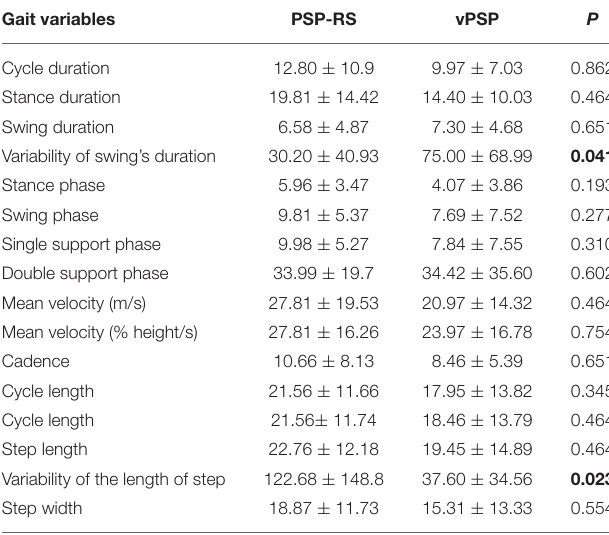
Data are shown in mean ± standard deviation. PSP-RS, Progressive Supranuclear Palsy with Richardson’s syndrome; vPSP, the other variant syndromes of Progressive Supranuclear Palsy. Significant results are highlighted in